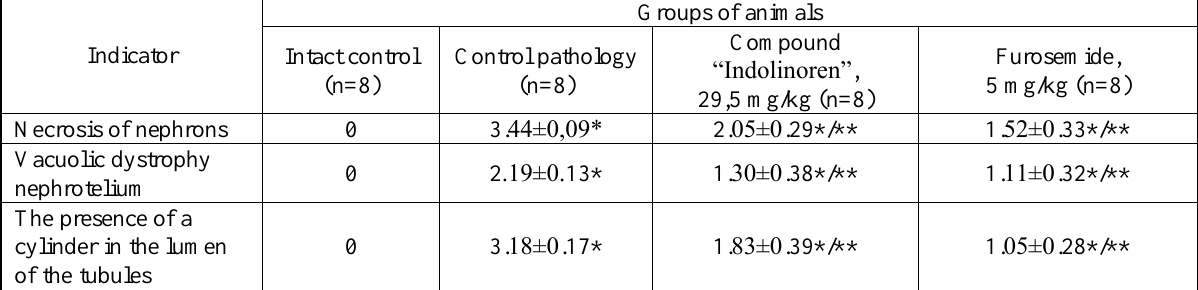
а b Fig. 5 Rat kidney with a model of glycerol acute renal failure on the background of the administration of furo- semide on the 3rd day. Fluctuations in the severity of cortical tubular disorders: a – weakly expressed (0.38 points); b – strongly expressed (2.38 points). Hematoxylin-eosin. × 250, × 200 Results of a semi-quantitative assessment of the effect of the investigated medications on damage of the tubular apparatus of rat’s nephrons,